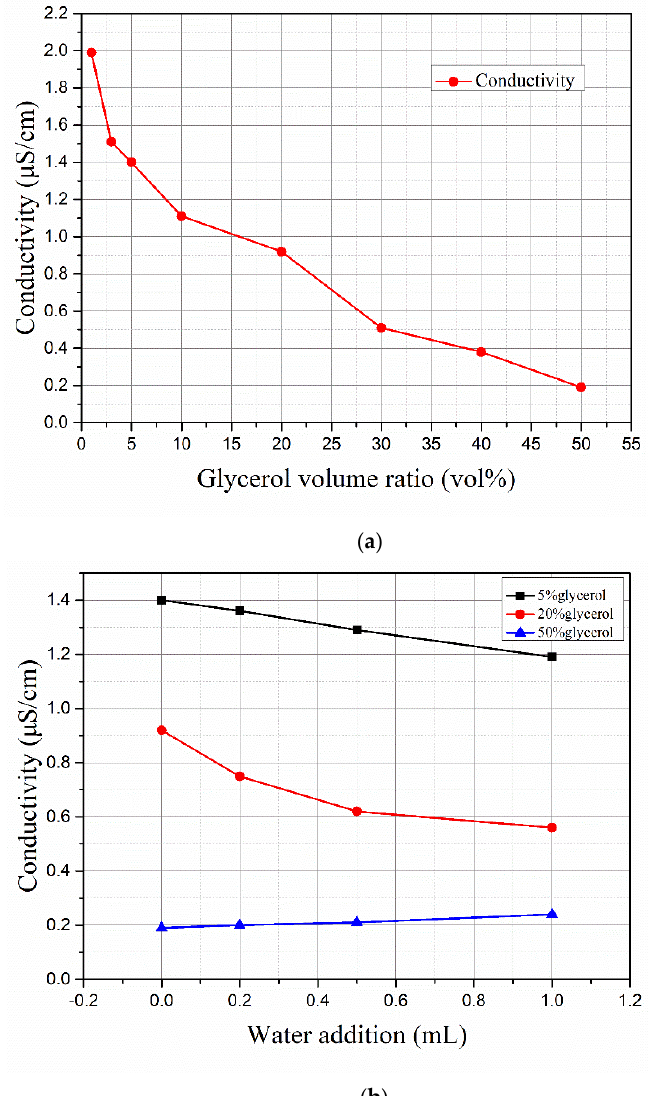
Figure 2. Variation of electrical conductivity of mixed fuels. ( a ) Change of conductivity with glycerol ratio under anhydrous condition. ( b ) Change of conductivity with glycerol ratio in the presence of water.